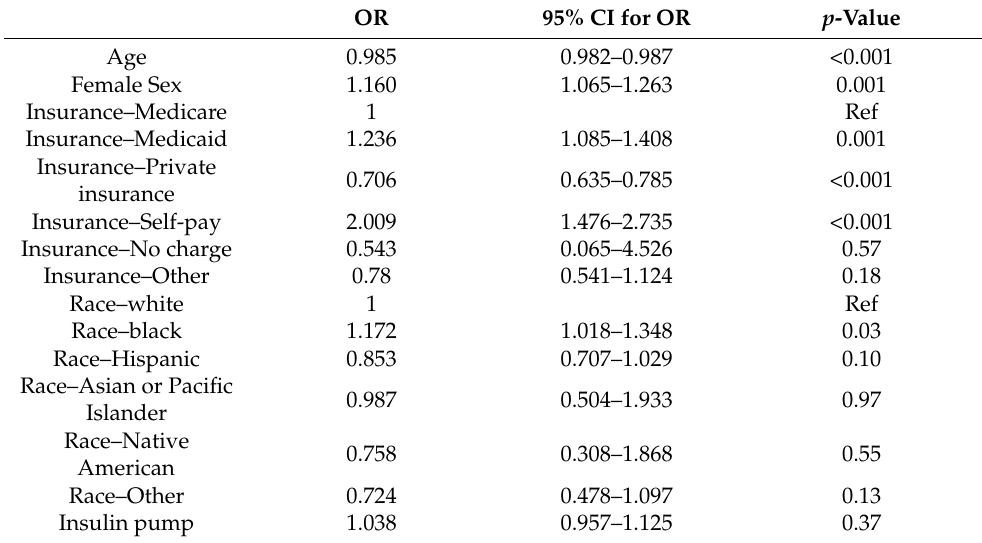
Table 3. Multivariate logistic regression model to predict occurrence of diabetic ketoacidosis. OR 95% CI for OR p -Value Age 0.985 0.982–0.987 <0.001 Female Sex 1.160 1.065–1.263